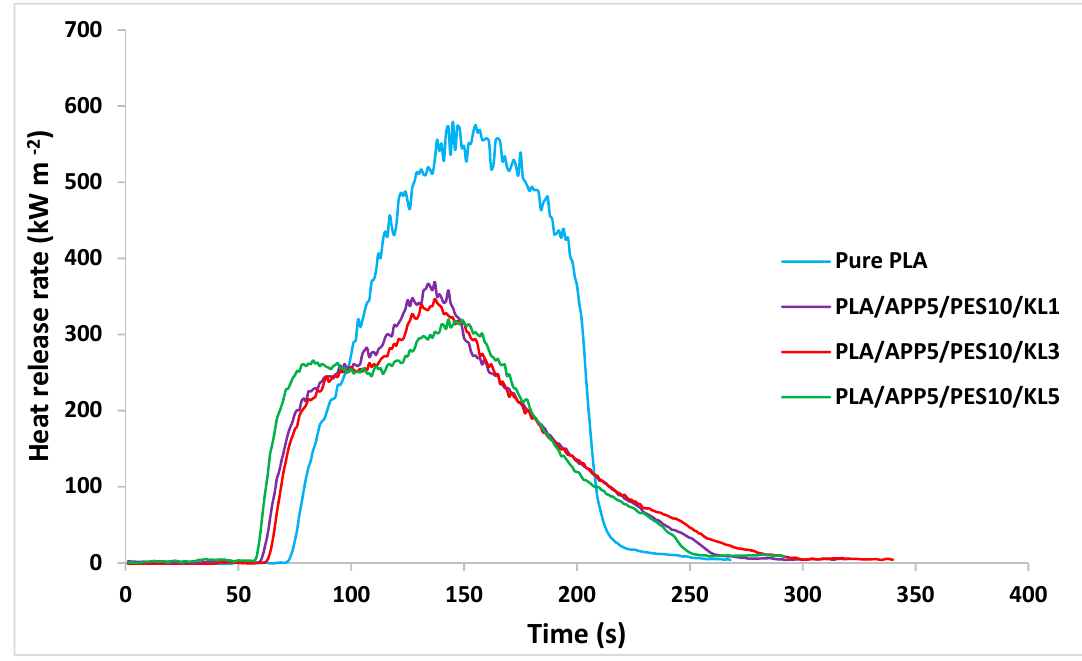
Figure 9. Heat release curves of pure PLA and FR PLA nonwoven fabric samples.